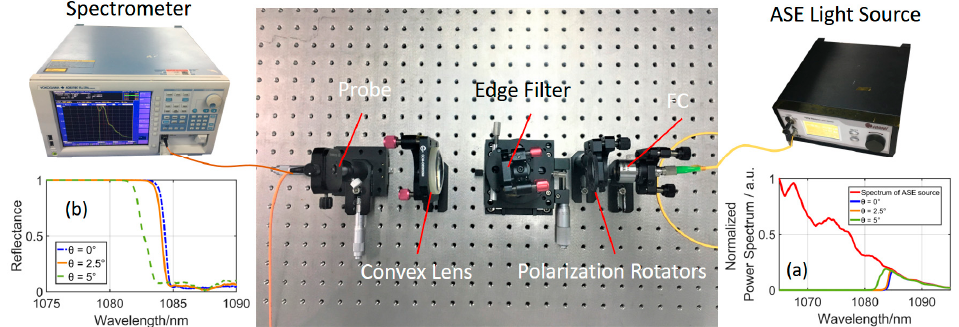
Figure 3. Test setup for measuring the reflectance curve of the edge filter. FC, fiber collimator; ASE light source, amplified spontaneous emission light source. Inset ( a ) shows the measured spectra; Inset ( b ) shows the experimental results of the reflectance curves under di ff erent incident angles (0 ◦ , 2.5 ◦ , and 5 ◦ ).